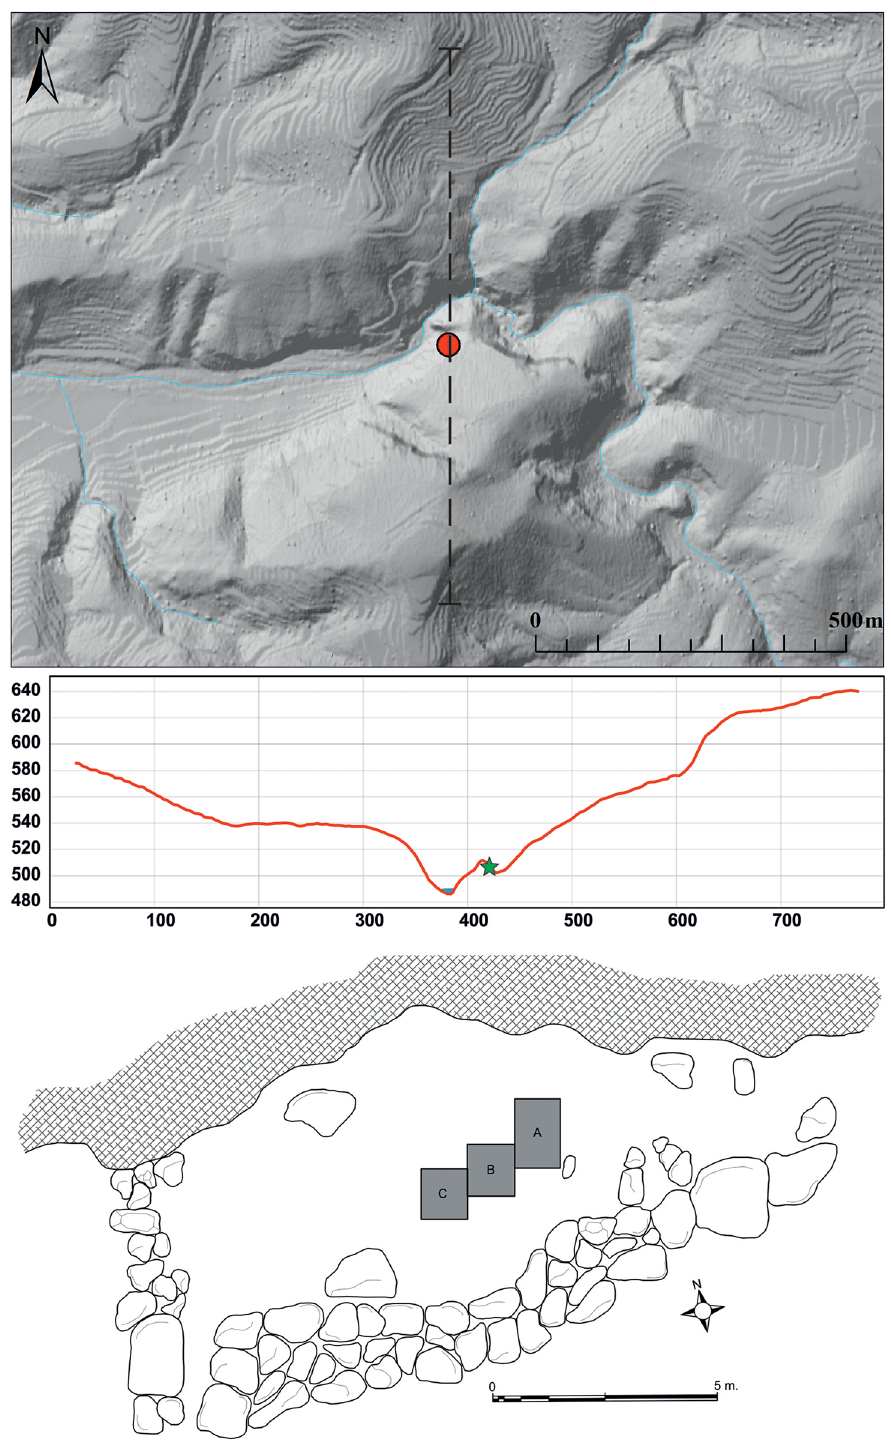
Figure 2: Location of Penya Roja de Catamarruc, topographic pro fi le, and planimetry of the shelter with indication of Asqerino ’ s